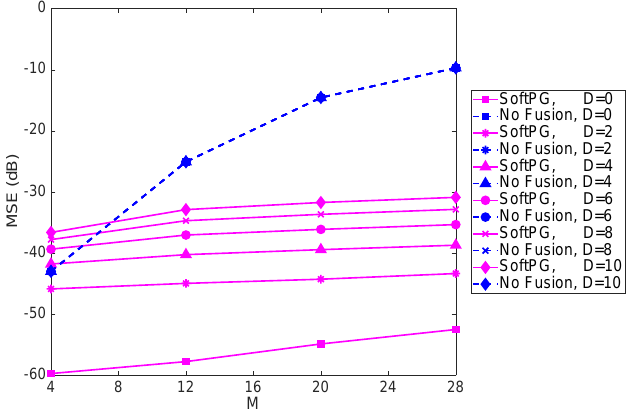
Figure 5. MSE as a function of M , the size of the state vector, for different values of delay. Number of observations per PE is